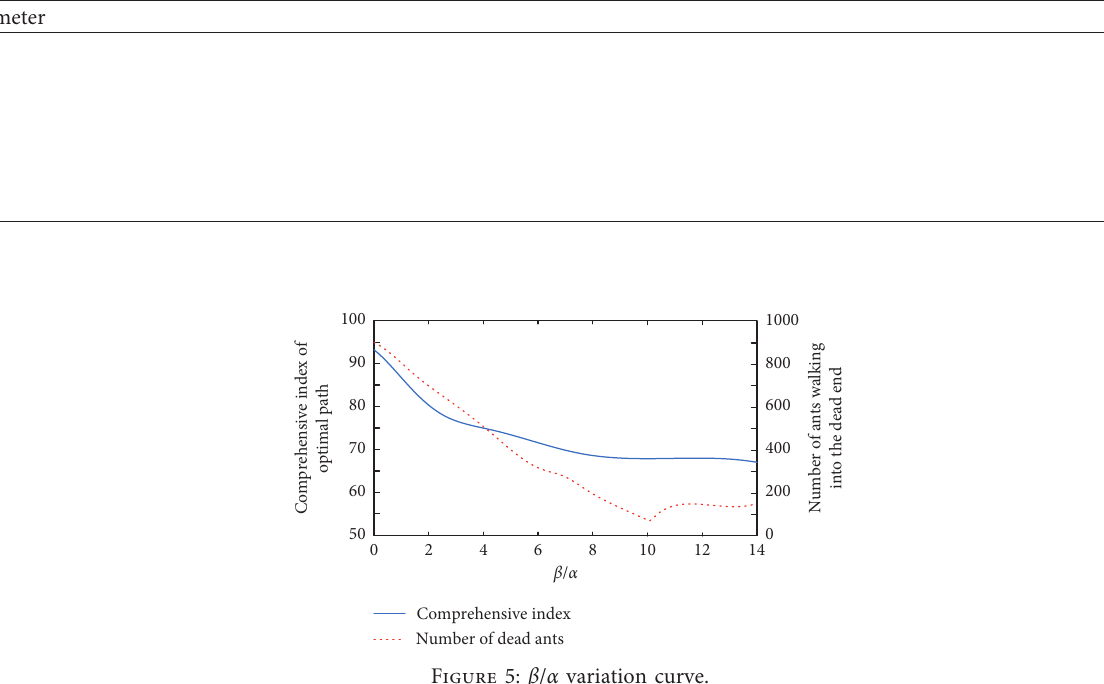
Table 1: Initialization parameters.